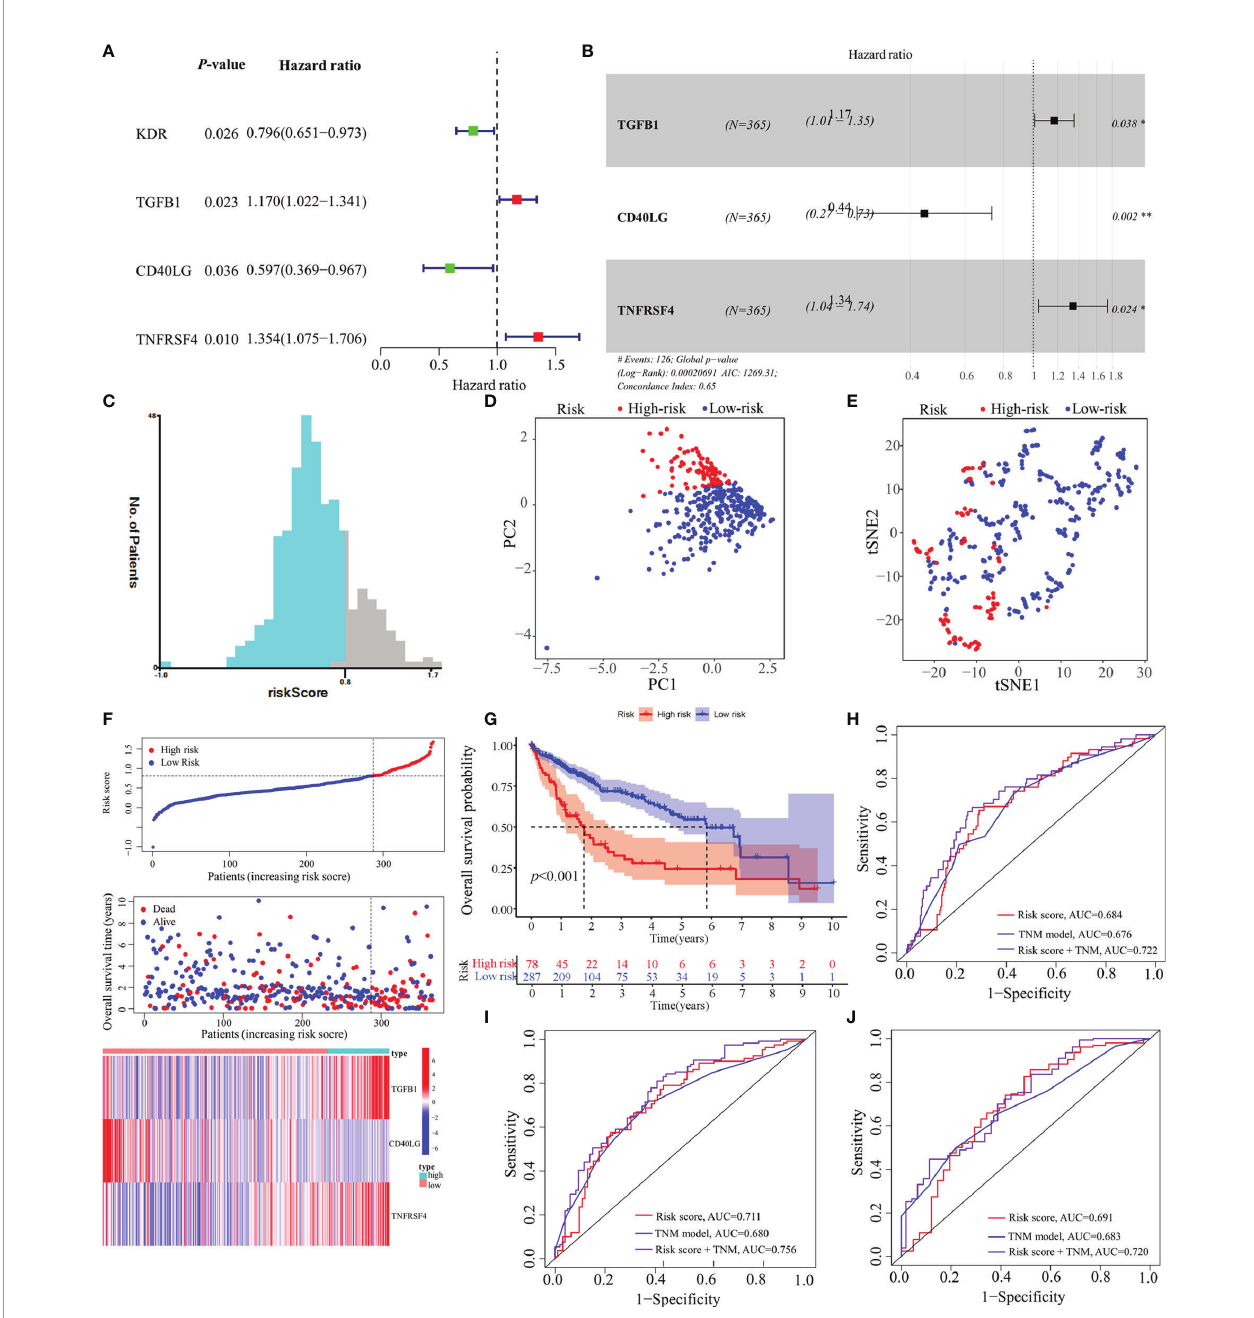
FIGURE 3 | Construction of a predictive model based on MED8-related immunomodulators. (A) Univariate Cox regression analysis of 25 immunomodulators. (B) Forest plot exhibiting the multivariate Cox regression results. (C) The optimal cut-off of predictive model. (D) PCA analysis of TCGA-LIHC cohort. (E) t-SNE analysis of TCGA- LIHC cohort. (F) Risk score, survival status and expression of MED8-related immunomodulators in high-risk and low-risk groups of TCGA-LIHC cohort. (G) Overall survival analysis in high-risk and low-risk groups of TCGA-LIHC cohort. (H – J) ROC analyses of 1- (H) , 3- (I) and 5-years (J) overall survival in TCGA-LIHC cohort. *: P < 0.05; **: P <